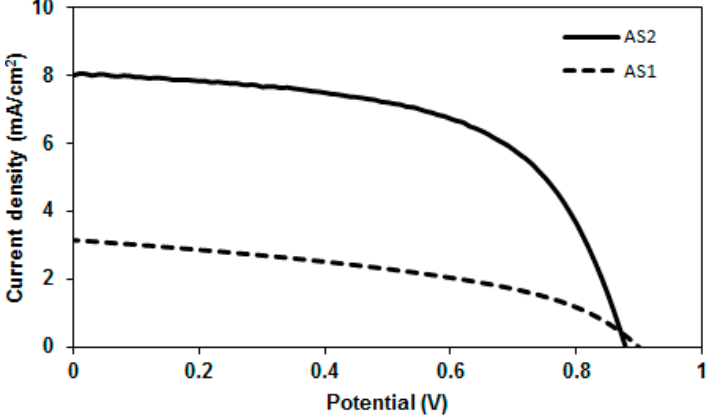
Figure 7. Current–voltage curves for the optimized devices based on AS2 and AS1 in blends with